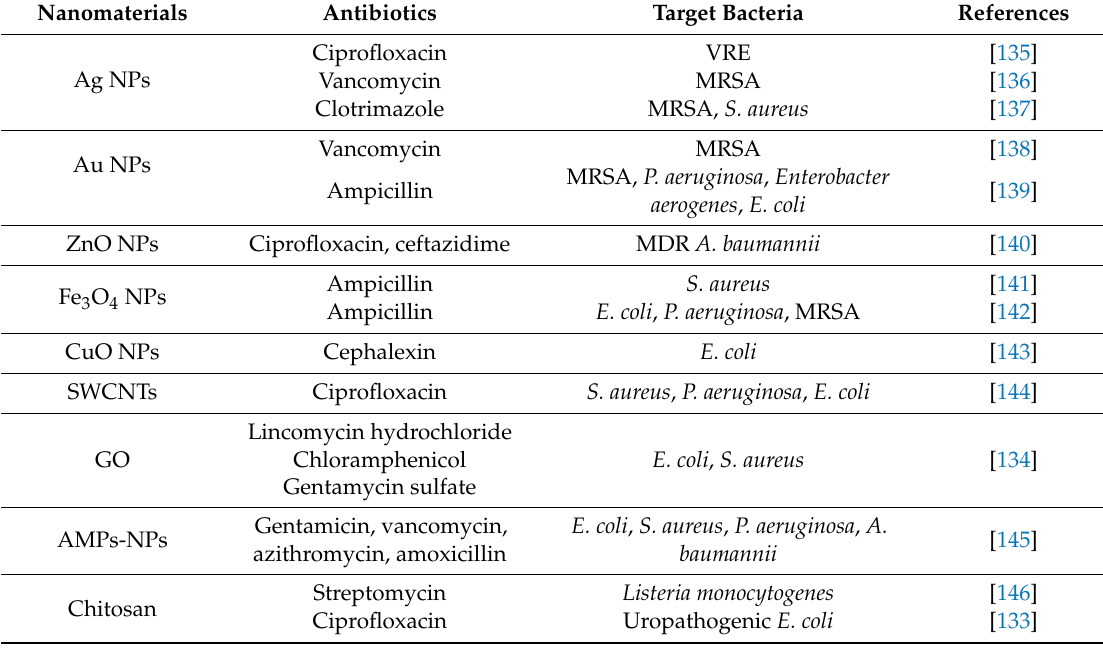
Table 3. Antibacterial activity of nanomaterials combined with